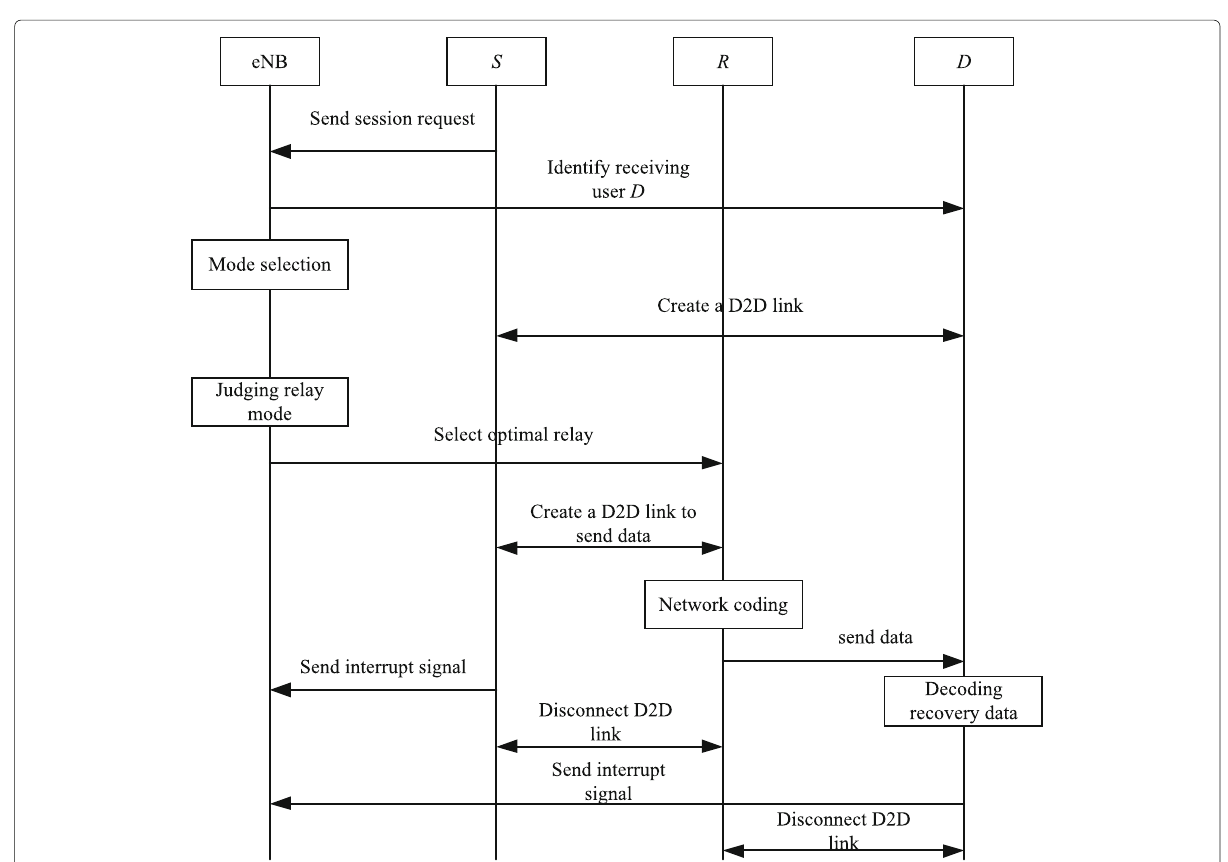
Fig. 3 The session establishment and communication based on network coding in RA-D2D